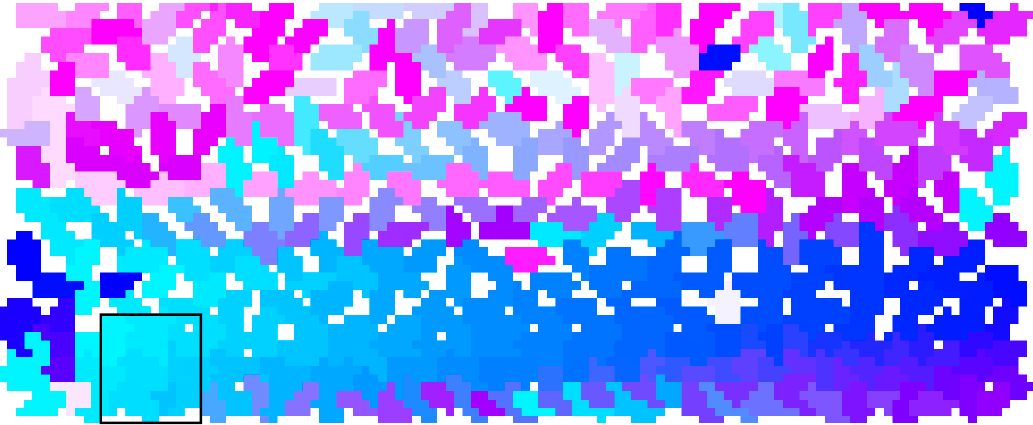
Figure 3. Local crowd density computation. Local crowd density is 10.49 people/m 2 in the 1 m 2 area enclosed by the black lines.